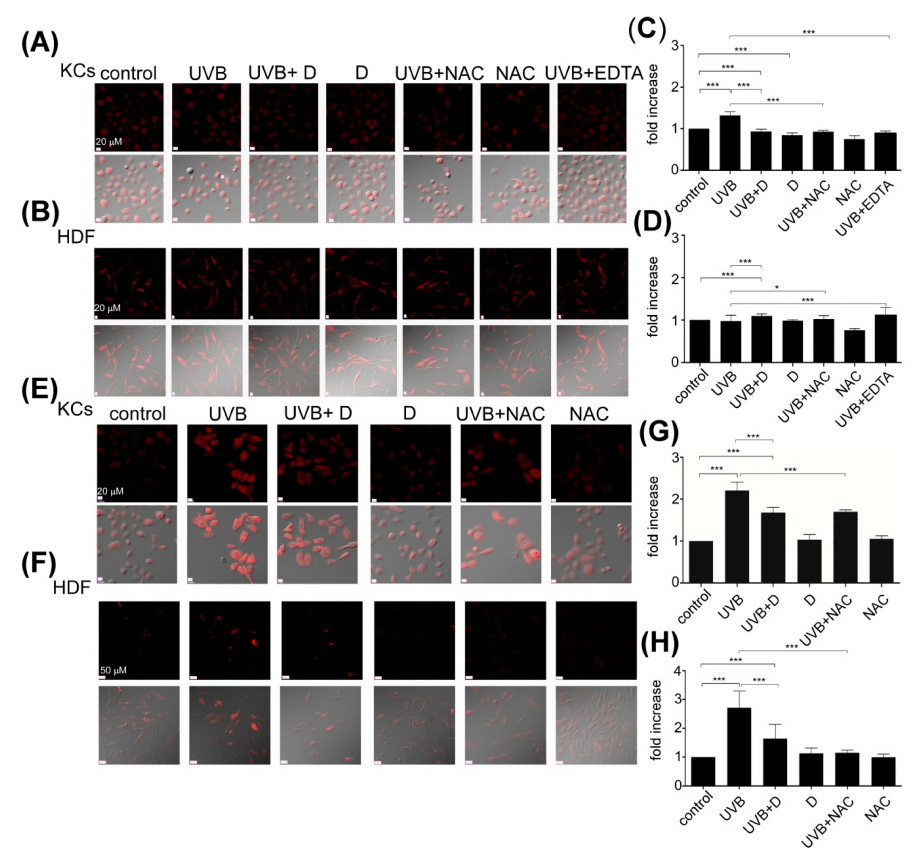
Figure 5. The effect of Derinat on UVB induced intracellular ROS production in skin cells. ( A ) KCs and ( B ) HDF were pretreated with Derinat and 0.5 mM NAC for 24 h and then irradiated with UVB. EDTA (1 mM) was applied after UVB exposure. The ROS generation was measured after 30 min of UVB irradiation by using 5 µ M dihydroethidium (DHE) staining. The intracellular ROS production level with an average fluorescence intensity of more than 150 cells from ( A ) and ( B ) is quantified in ( C ) KCs and ( D ) HDF (***, p < 0.001; *, p < 0.01). To further investigate the intracellular ROS generation in ( E ) KCs and ( F ) HDF, the cells were cultured in normal medium for 24 h after UVB-exposure, and the intracellular ROS production was detected with a confocal microscope using DHE staining. The quantification of intracellular ROS production from ( E , F ) is shown in ( G , H ) (***, p